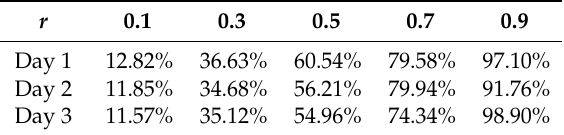
Table 5. Portion of the customers for the increased social